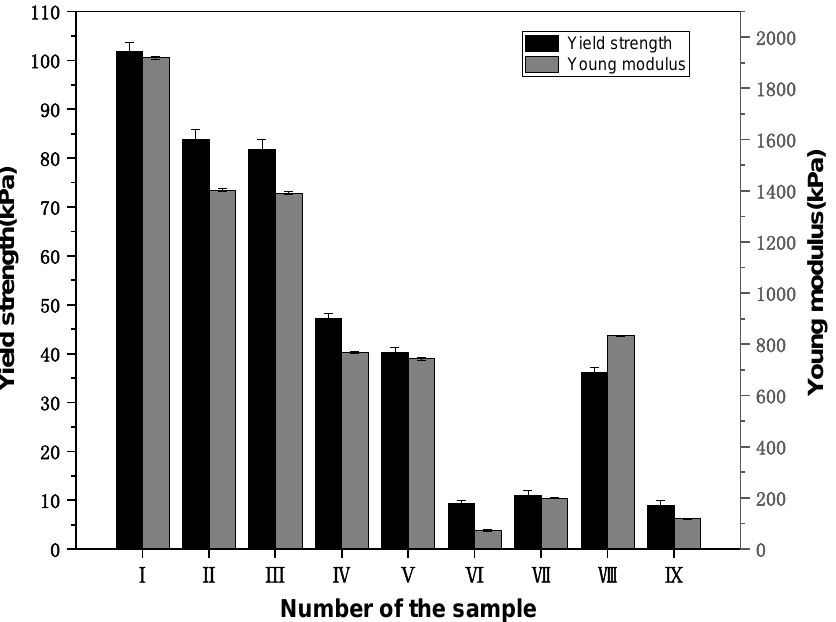
Figure 12. Yield strengths and Young’s moduli of materials with different water contents. As shown in Figure 13, with continuous increases in water content, the stress at which materials reached a lower cushion coefficient gradually decreased. Sample I had a low water content, and the stress at the low point for C was too high and not suitable for cushioning protection of lightweight items.